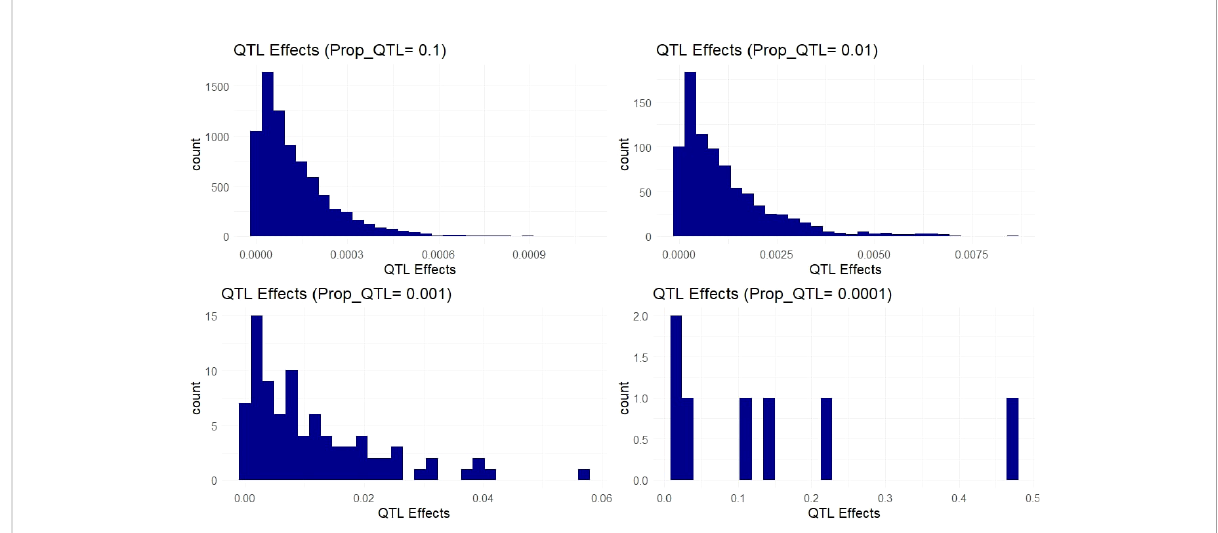
FIGURE 4 Simulated QTL Effects. Histograms show count of QTL effects in one example simulation. Each facet shows a genetic architecture with different proportions of the markers acting as QTL (resulting in ~ 6600, 660, 66, and 6 QTL on average). The x-axis represents the positive effect of carrying the ancestral allele at a given